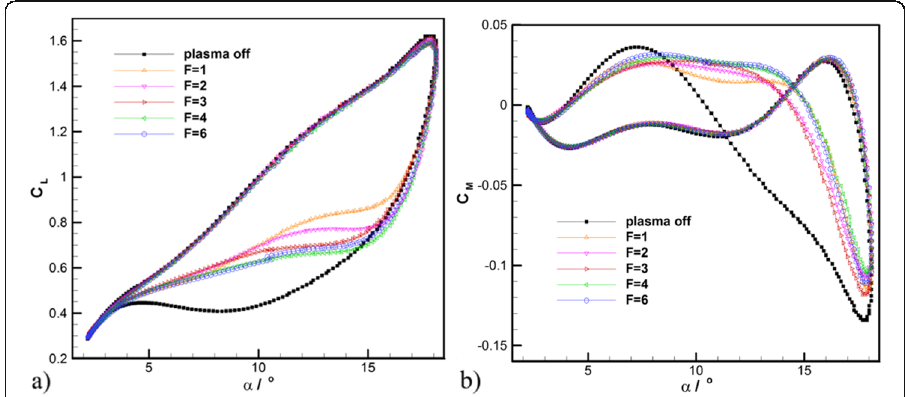
Fig. 4 Dependence of C L and C M on normalized burst